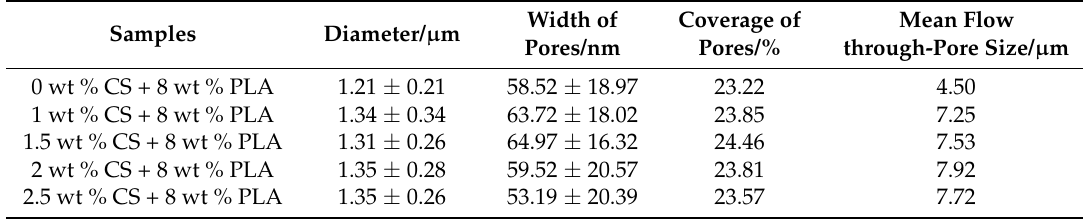
Table 3. Characterization of fibres fabricated with different mass